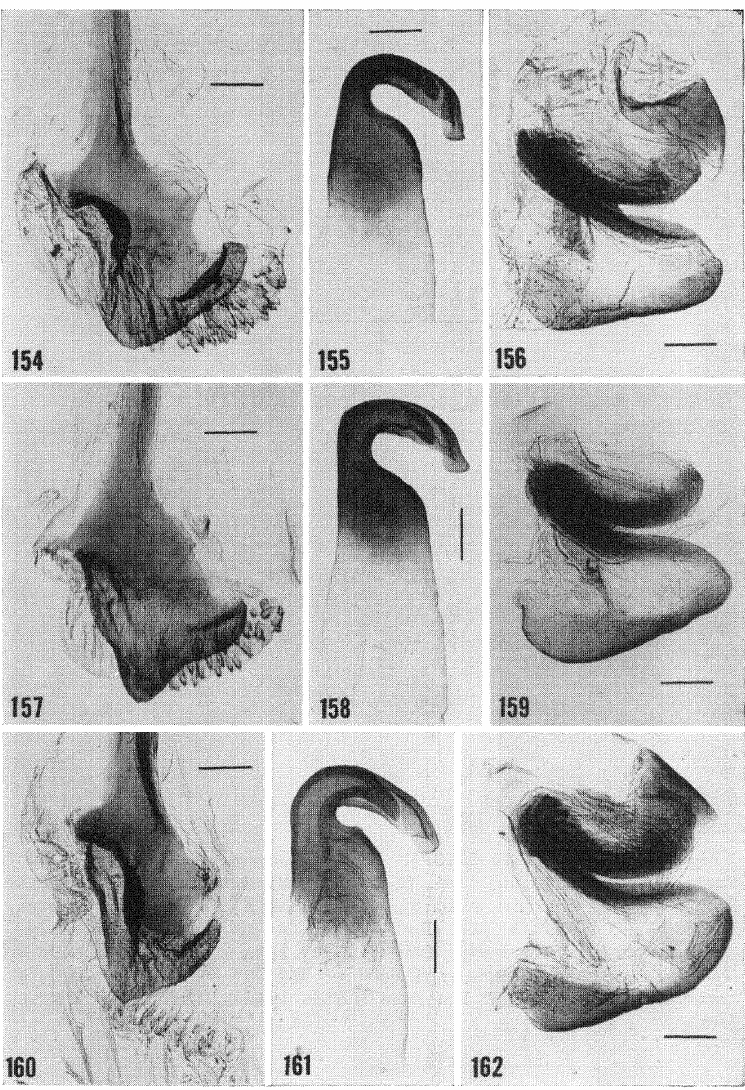
Figs. 154-162. 154-156. (17 ANSP). Petasodes dominicana. (from speci- men shown in Fig. 118. 157-159. (7 ANSP). Petasodes moufeti. (from specimen shown in Fig. 119). 160-162. (18 ANSP). Petasodes reflexa. (from specimen shown in Fig. 120). The prepuce has been pulled down so that the lightly selerotized spines are visible. (scale- 0.3